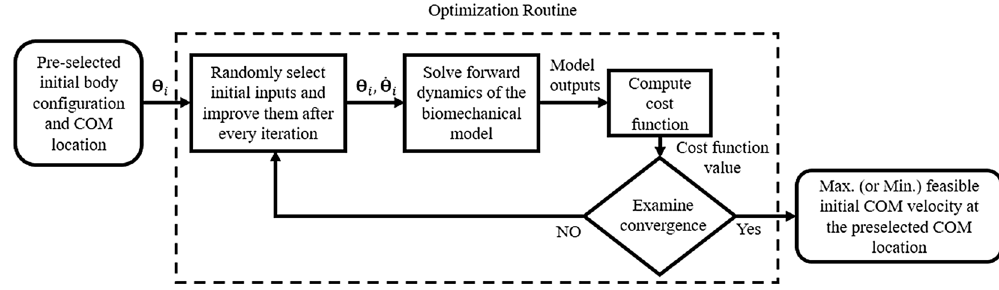
Figure 1. Illustration of optimization and simulation process used to obtain the FSR limits for perturbed walking conditions, based on the perturbation type and level. The output of the optimization process is the maximum and minimum feasible normalized COM velocity for every initial COM position 16,23 . External perturbations were in the form of vertical and horizontal displacements and sagittal rotations of the BOS. The FSR limits were obtained for various frequencies and amplitudes of perturbation (ranging from ± 1 cm to ± 6 cm in the vertical and horizontal directions and ± 0.6 degrees to ± 3 degrees in